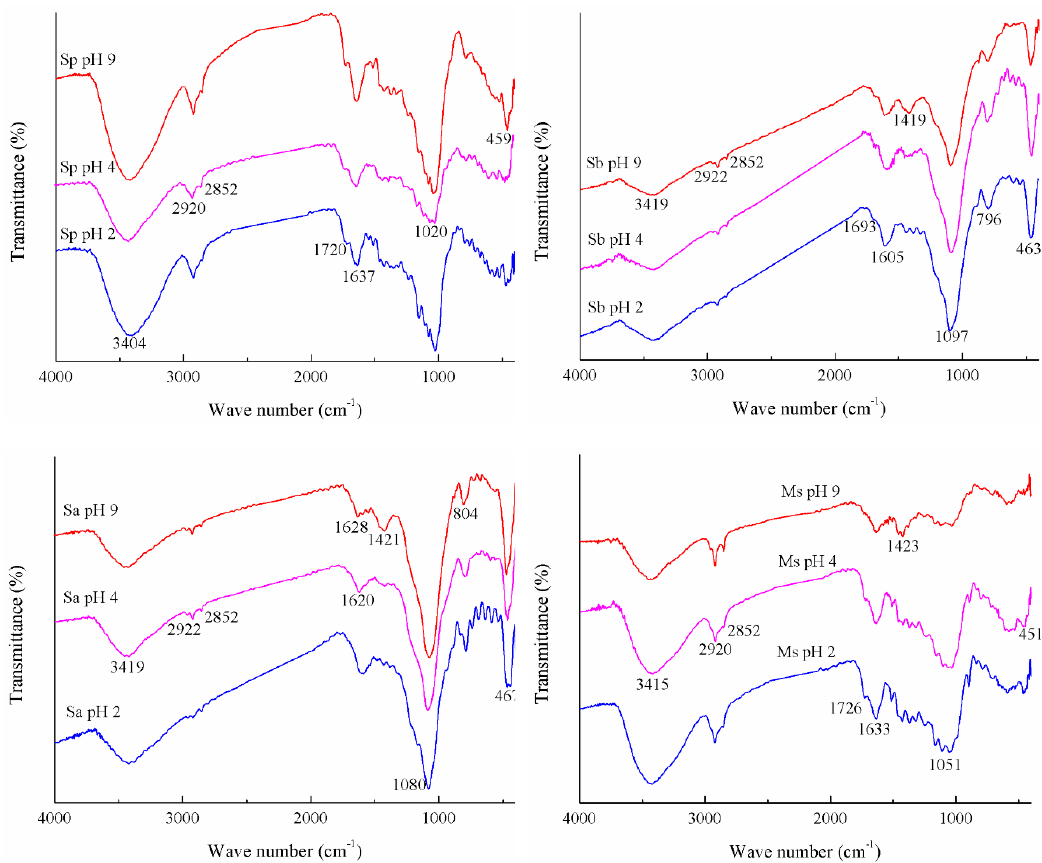
Figure 1. Fourier transform infrared (FTIR) spectra of Cd(II) adsorbed by the four biosorbents under different pH values.